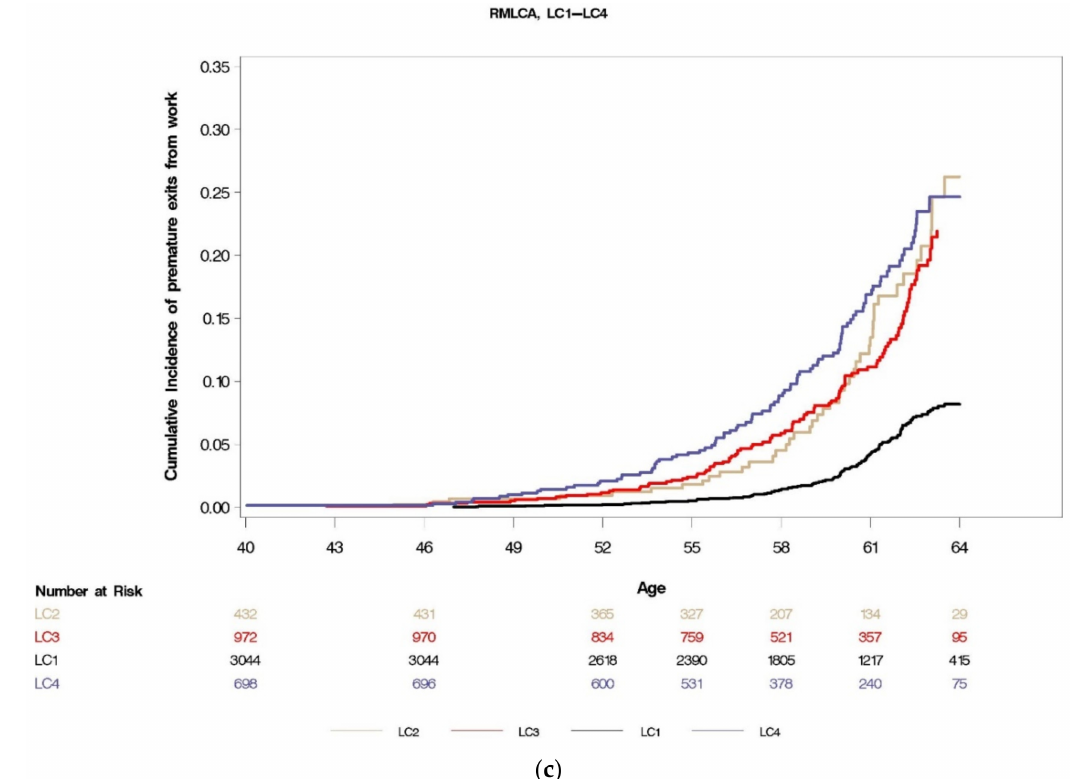
Figure 2. ( a ) RMLCA model of General Health Perception and Problems of Initiating Sleep (LC1 as a reference). In this model the predictive power of LC4 is at its maximum (HR = 6.48). ( b ) RMLCA model of General Health Perception and Nonrestorative Sleep (LC1 as a reference). In this model the predictive power of LC3 is at its maximum (HR = 4.21). ( c ) RMLCA model of Social functioning and Nonrestorative Sleep (LC1 as a reference). In this model the predictive power of LC2 is at its maximum (HR =